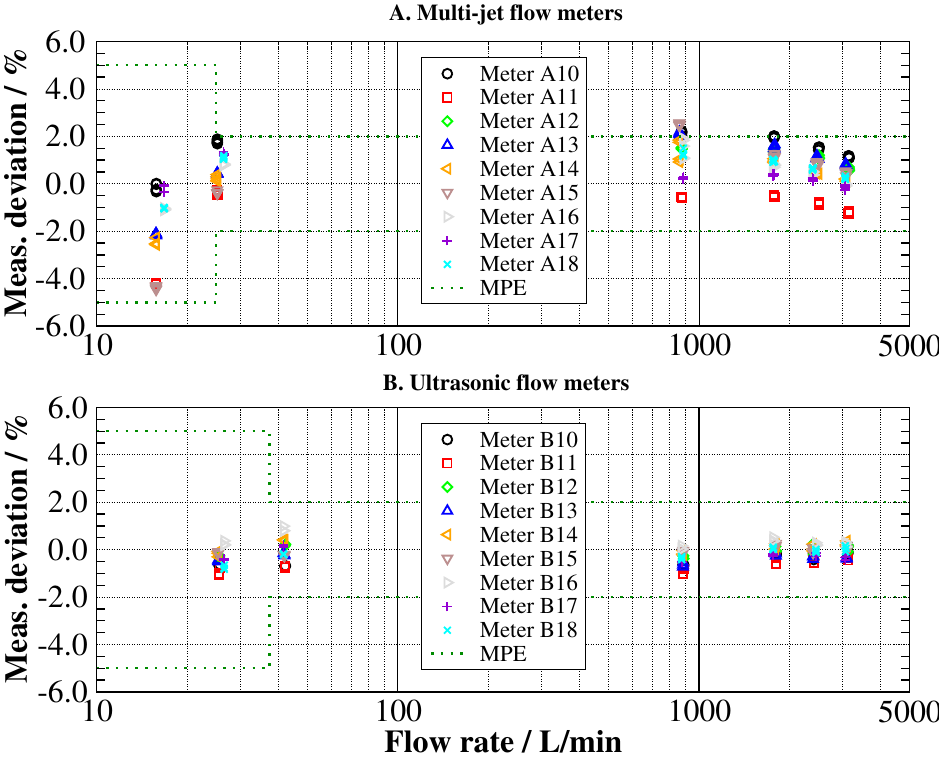
Figure 10. Top: ( A ). Calibration results of the B meters multi-jet cold water meters after the pH value tests; Below: ( B ). Calibration results of the Kamstrup ultrasonic cold water meters after the pH value